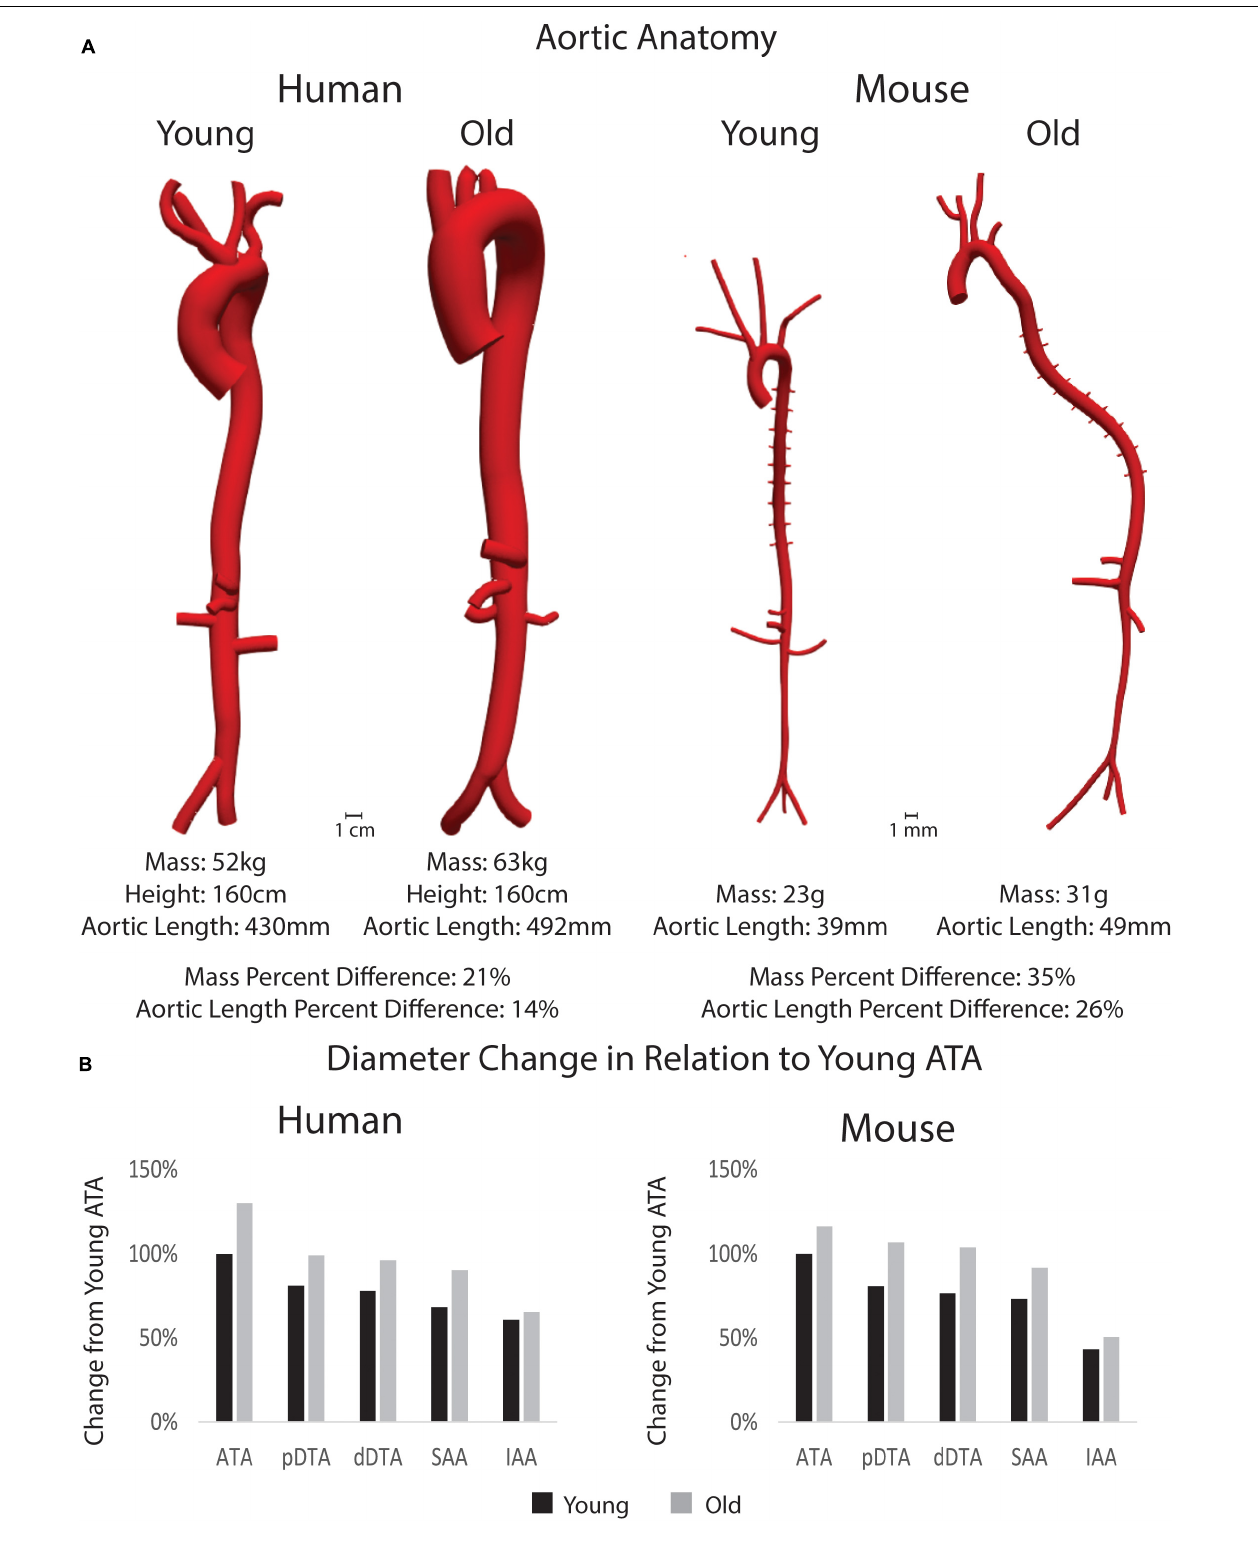
FIGURE 3 | (A) 3D models of the aorta and main branches for each subject along with body mass, height (for humans), and aortic length. Percent differences between young and old adults for each species is shown for mass and aortic length. Anatomical models are shown in the same scale between age groups, but not between species. (B) Percent changes in inner diameter by region (pDTA, proximal descending thoracic aorta; dDTA, distal descending thoracic aorta; SAA, suprarenal abdominal aorta; and IAA, infrarenal abdominal aorta) of the aorta in comparison to the young ascending thoracic aorta (ATA_ diameter) for both species.